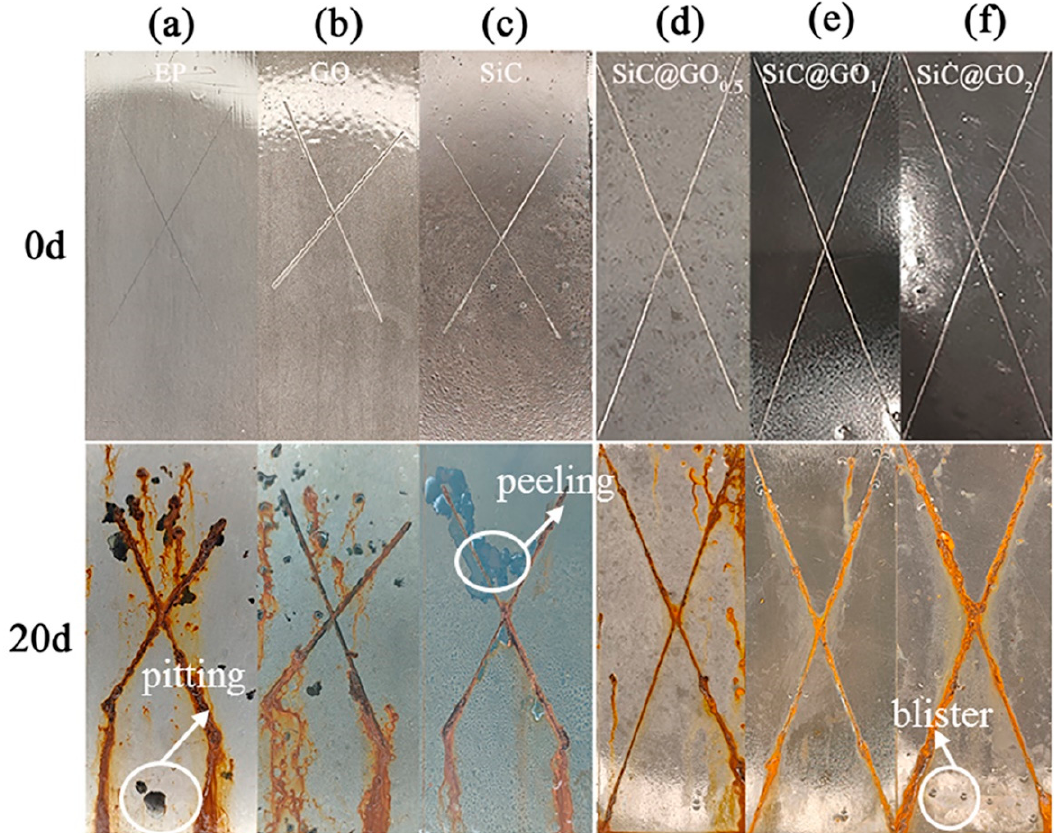
Figure 15. Images of epoxy coatings containing ( a ) neat EP, ( b ) GO 1 , ( c ) SiC 1 , ( d ) SiC-G@GO 0.5 , ( e ) SiC-G@GO 1 , and ( f ) SiC-G@GO 2 before and after exposure to the salt spray test for 20 d.